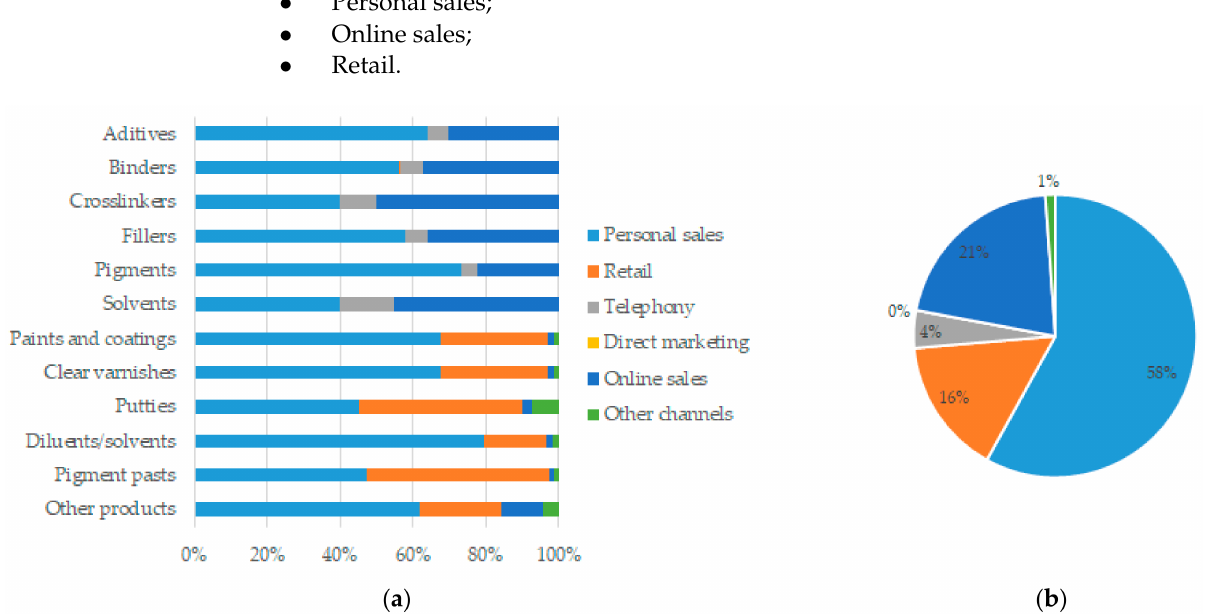
Figure 3. Sales of products to other companies (B2B): ( a ) Sales percentage of each product category by individual sales channel. ( b ) The total percentage of sales by individual sales